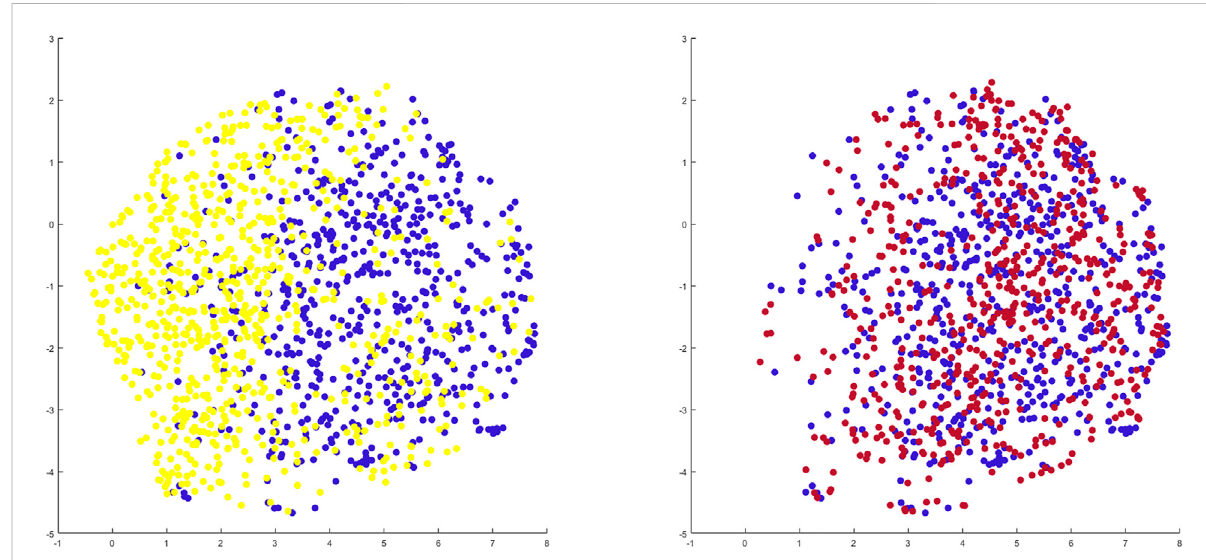
FIGURE 8 2D representation of multiple shape spaces using UMAPS The depicted shape spaces represent the healthy control population (blue), the virtually reconstructed healthy twins from the diseased subjects (yellow) left panel and the virtually reconstructed healthy twins from the arti fi cially deformed and misaligned healthy control samples (red) right panel. Largely overlapping shape spaces are observed for the heathy control subjects and their virtual reconstruction following arti fi cial deformation whereas distinct phenotypes are delineated between the healthy control samples and the virtual healthy twins, reconstructed out of the arthritic